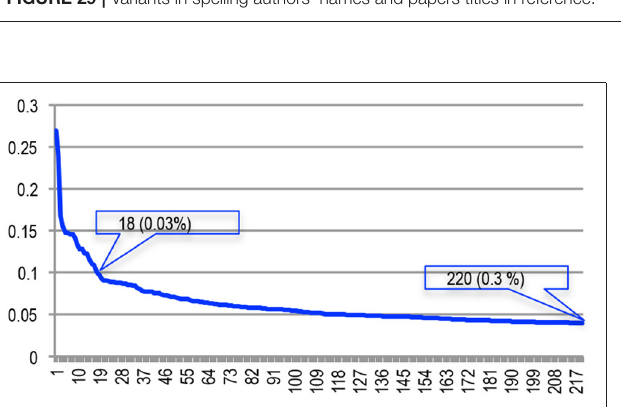
FIGURE 29 | Variants in spelling authors’ names and papers titles in reference.